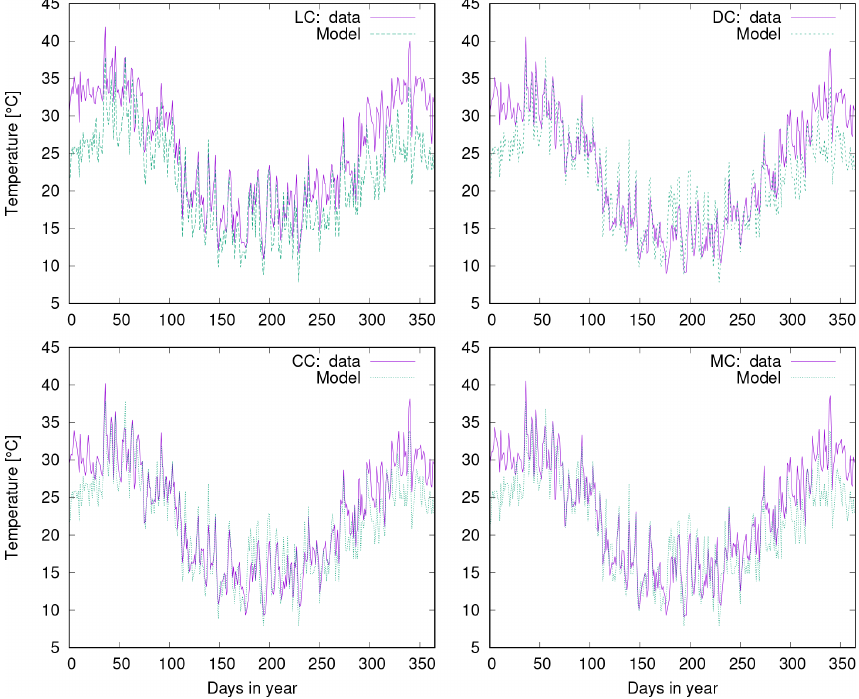
Figure A4. Comparison of measured and simulated surface temperature for one field site and four biocrust types at Soebatsfontein. The abbreviations in the figure legend stand for light cyanobacteria-dominated (LC), dark cyanobacteria-dominated (DC), chlorolichen-dominated (CC), and moss-dominated (MC)